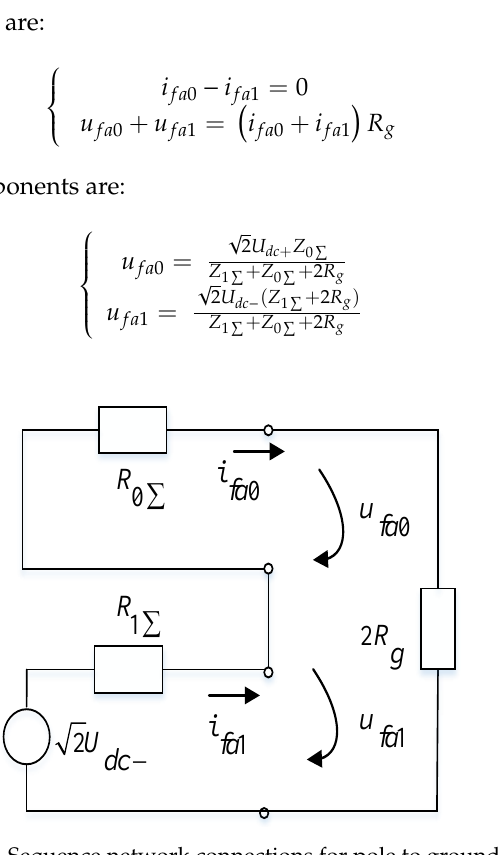
Figure 11. Sequence network connections for pole to ground fault .